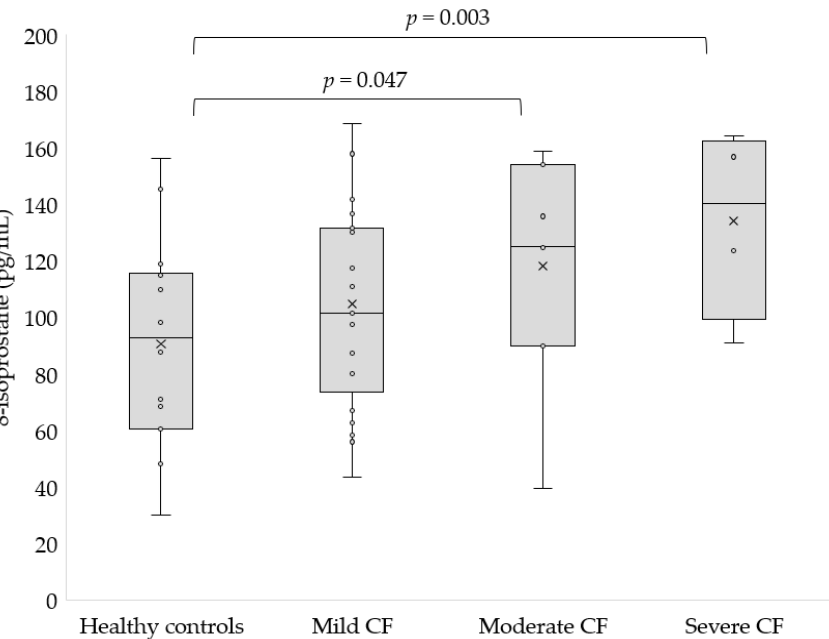
Figure 6. Concentration of 8-isoprostane in the serum of patients with mild, moderate and severe CF as compared to the control group.